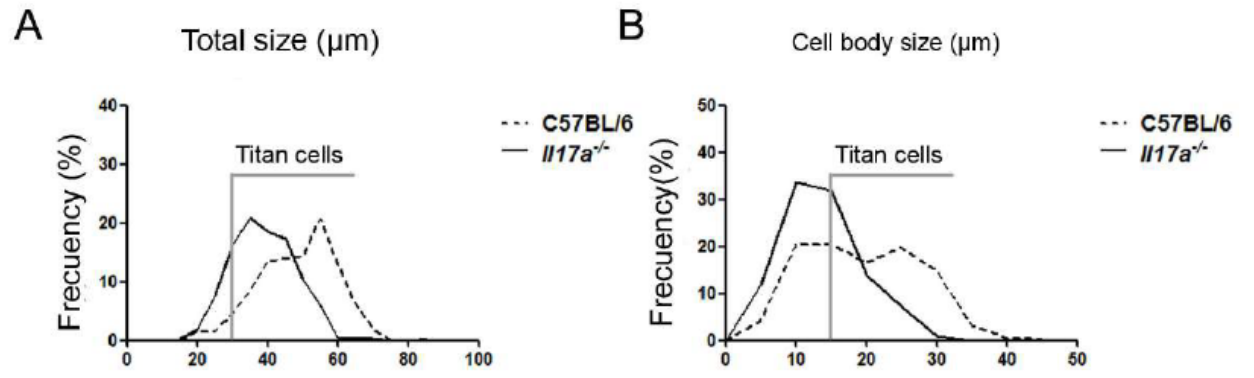
Figure 2. Size distribution of C. neoformans in C57BL/6J and Il17a -/- mice. Frequency representation of total cell size ( A ) and cell body size ( B ) of C. neoformans WT H99 cells isolated from C57BL/6J mice (dotted line) and Il17a -/- mice (black line) after 9 days of infection with a dose of 10 6 cells/mouse.